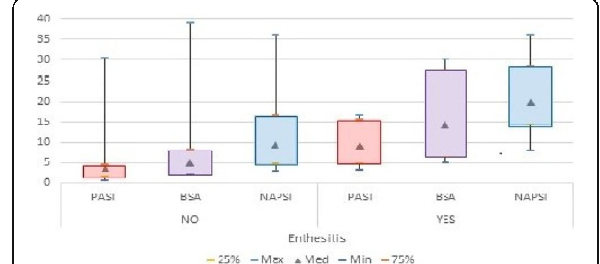
Fig. 1 (abstract P398). Enthesitis association to Skin and Nail